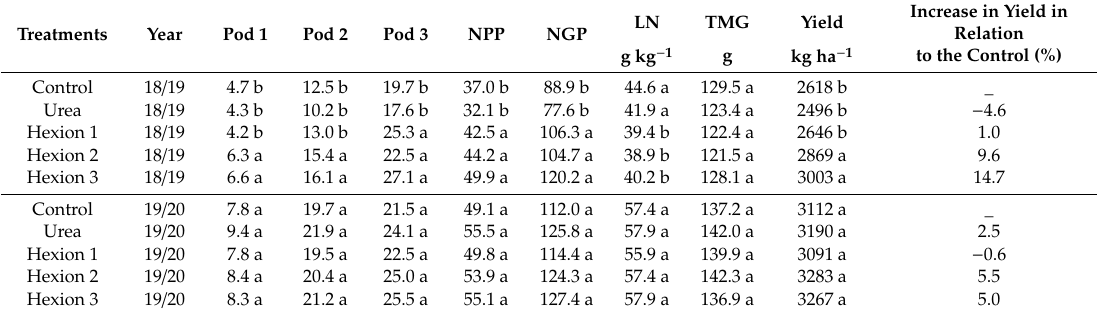
Table 2. Average data of pod one grain (POD 1), pod two grain (POD 2), pod three grain (POD